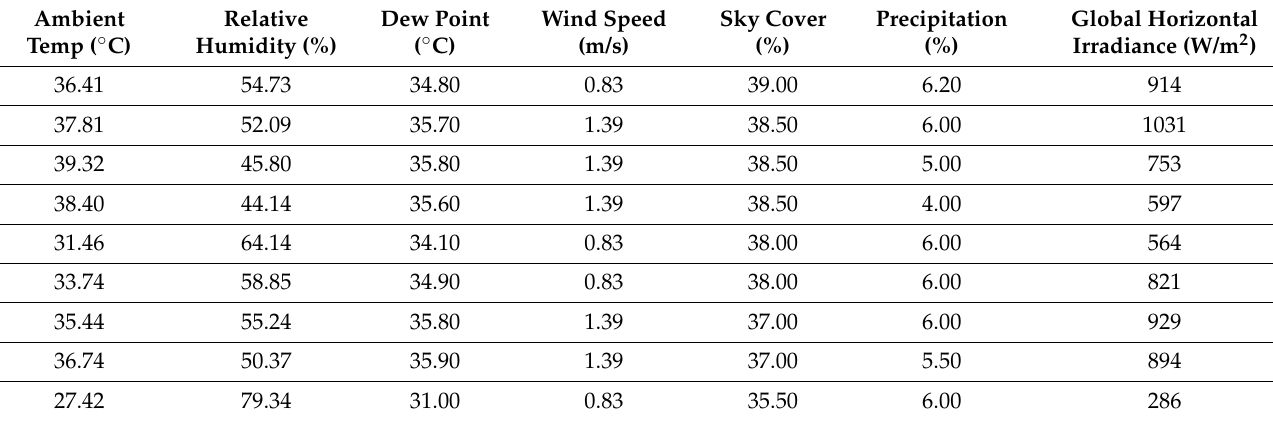
Table 3. Initial regression results for irradiance prediction.